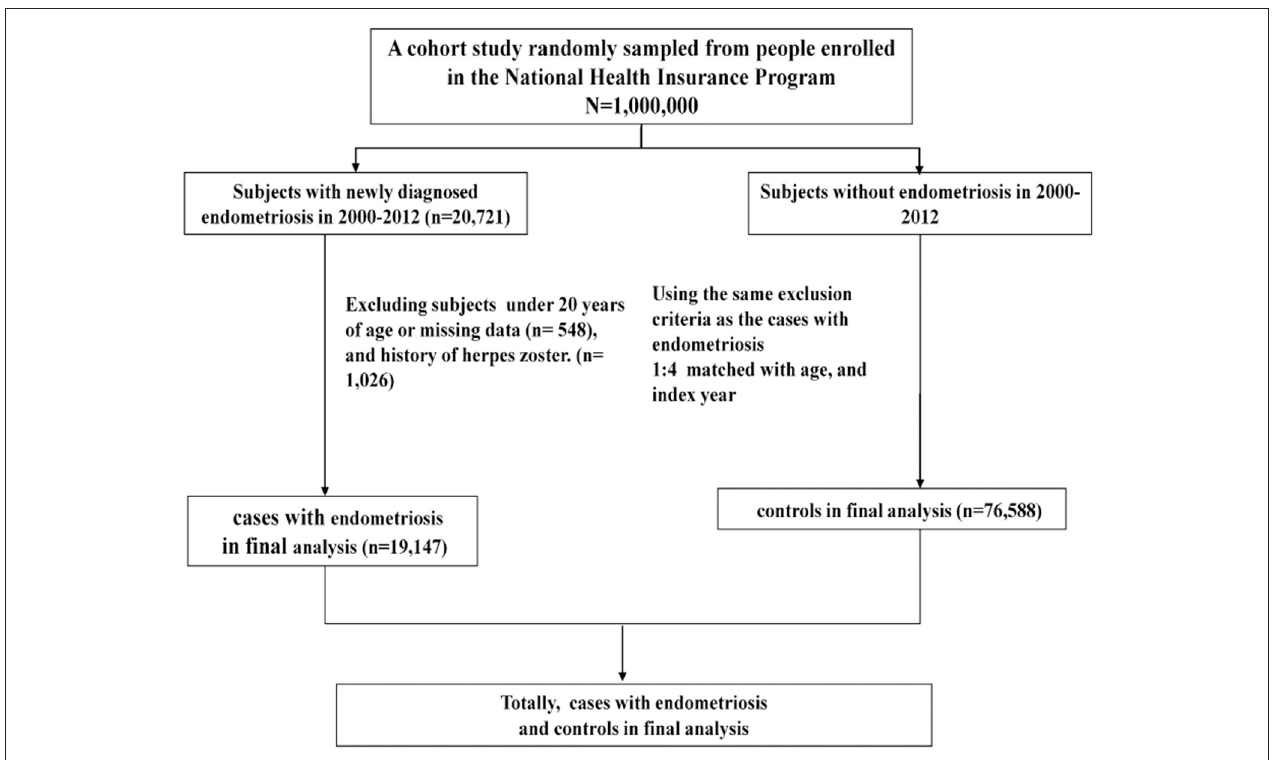
FIGURE 1 | The procedure of selecting patients.